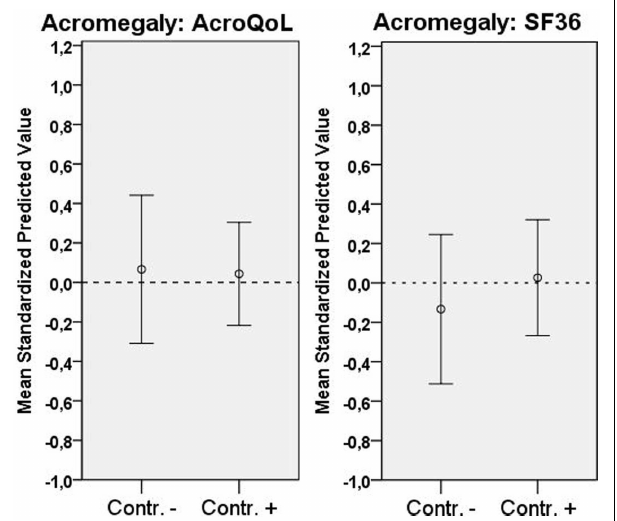
FIGURE 1 | Distribution of QoL according to scale (mean standardized predicted values), and biochemical status . Error bars represent 95% CI.